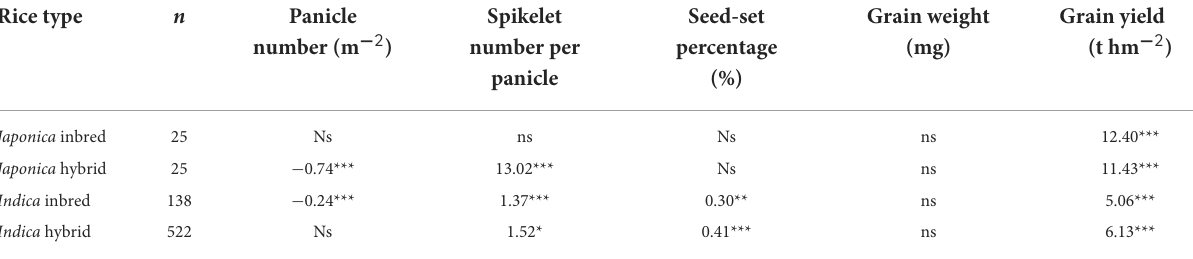
TABLE 3 Genetic gain (%) of yield traits in high grain quality rice